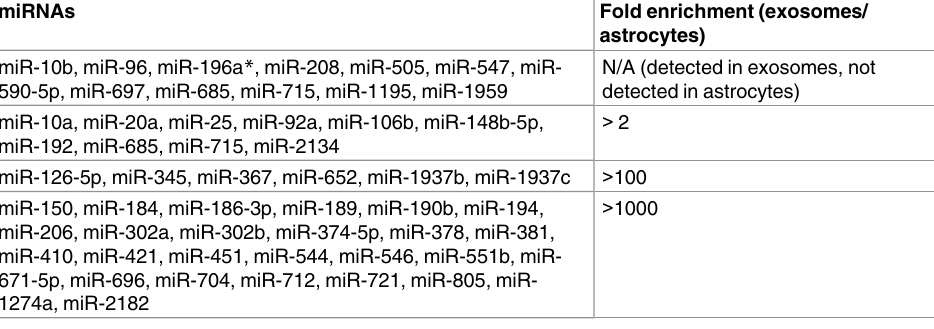
Table 2. miRNAs enriched in exosomes compared to astrocytes. miRNAs